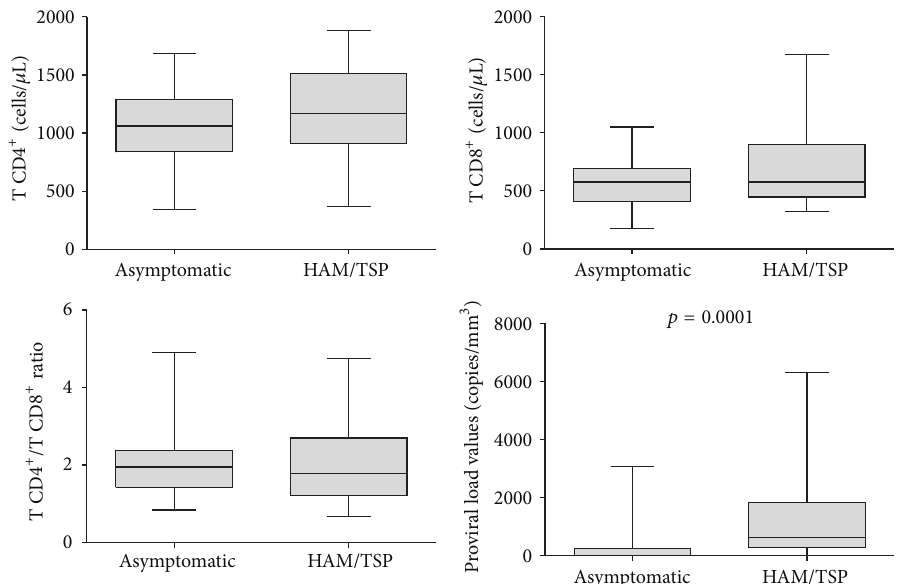
Figure 3: CD4 + /CD8 + T-cell and proviral load measurements in the HAM/TSP and asymptomatic